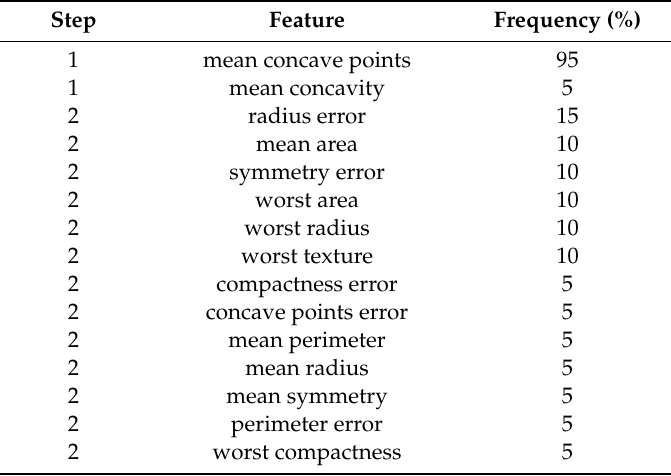
Table 6. The most frequent feature combinations—UCI-BCW dataset, 20 runs. For each step, the features that were selected at that step are listed with the percentages of their occurrences at that step among runs for the newly proposed method.